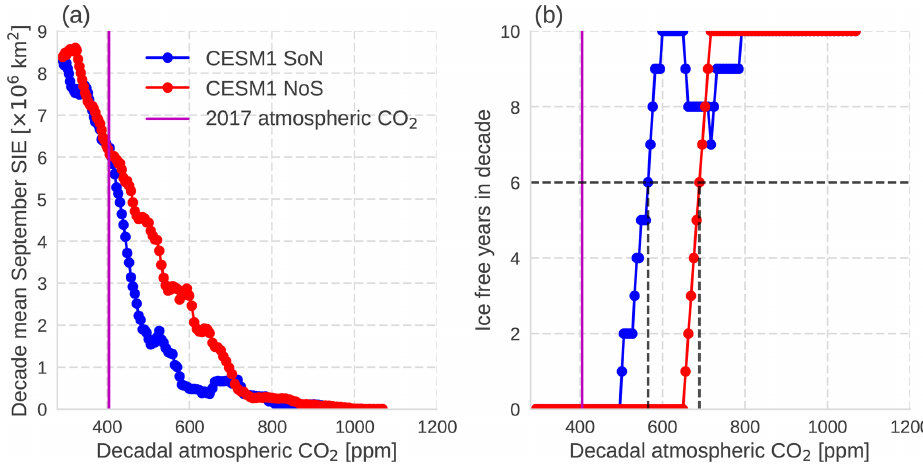
Figure 3. Changes in September Arctic sea ice under 1%yr − 1 CO 2 increases for CESM1 SoN (blue) and CESM1 NoS (red) as a function of decade-mean atmospheric CO 2 . (a) The decadal mean sea ice extent and (b) the number of years within that decade for which SIE < 1 × 10 6 km 2 , commonly taken as representative of an ice-free Arctic Ocean basin. The atmospheric CO 2 concentration in 2017 is shown as a vertical magenta line and the dashed lines in (b) identify the decade-mean atmospheric CO 2 level at which the majority of simulated years have SIE < 1 × 10 6 km 2